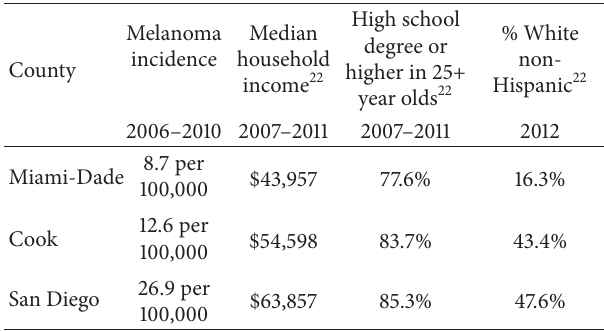
Table 2: Melanoma incidence and demographic information